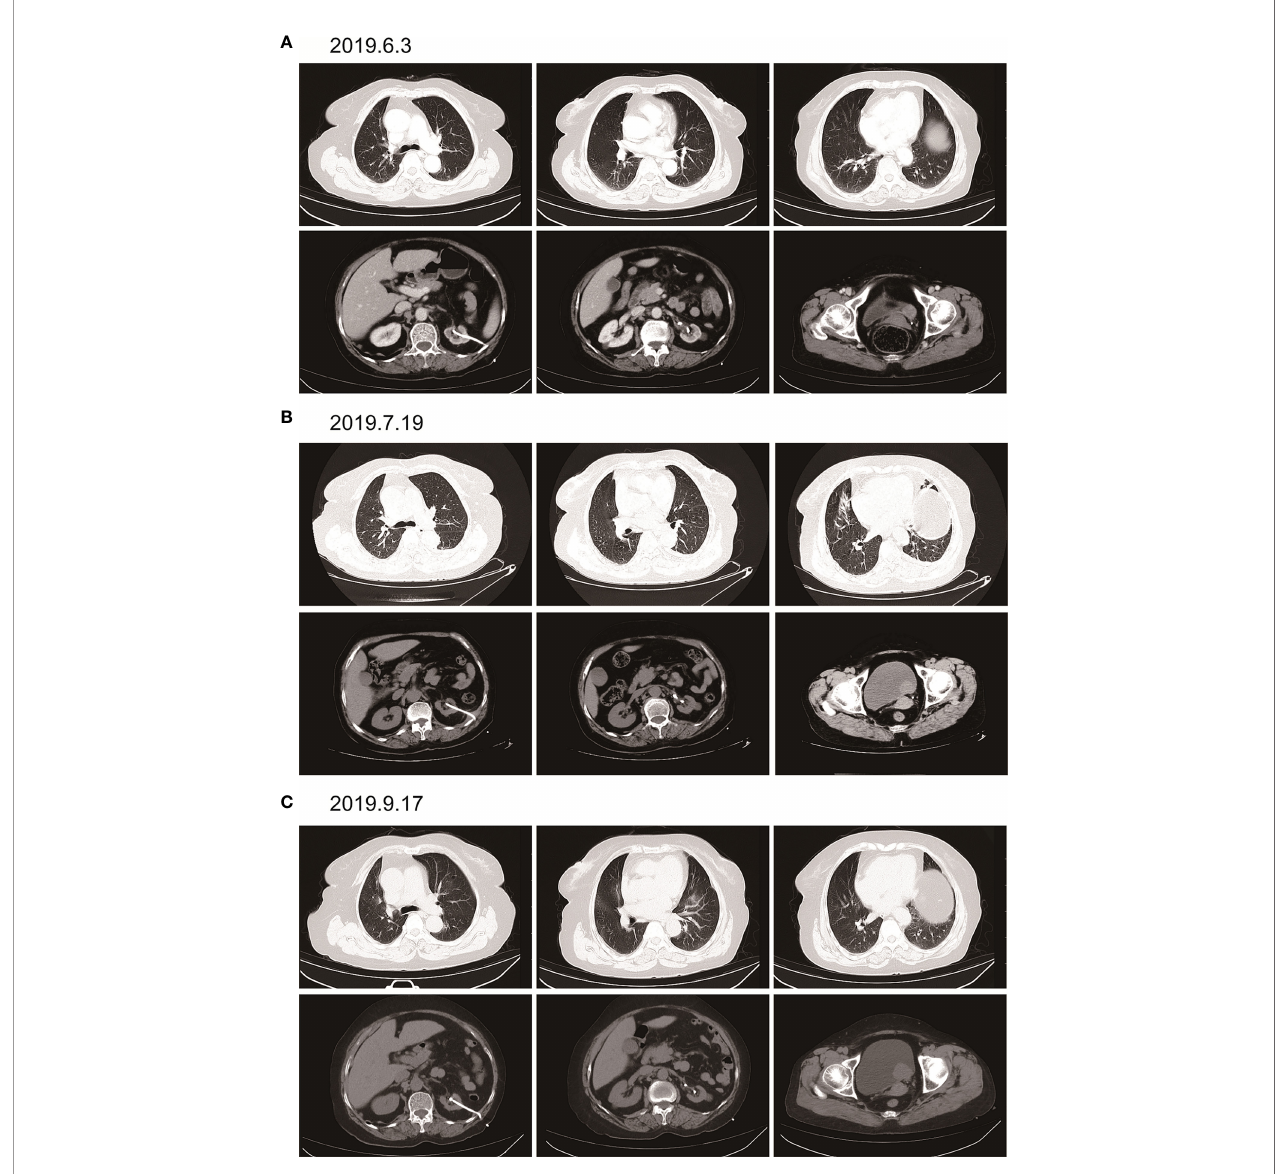
FIGURE 2 | Imaging examination after single-agent gemcitabine chemotherapy. (A) (2019.6.3) after two cycles of gemcitabine. Multiple round small nodules are seen in both lungs, with clear borders and reduced size compared to the previous ones. A dense mass of soft tissue at the entrance of the ureter on the left side of the bladder, with a size of about 25mm*22mm, and a clear boundary. (B) (2019.7.19) after 4 cycles of gemcitabine. Multiple round-shaped nodules in both lungs, with clear boundaries and slightly smaller than before. A dense mass of soft tissue at the entrance of the ureter on the left side of the bladder, with a size of about 25mm*22mm, with a clear boundary. (C) (2019.9.17) after 6 cycles of gemcitabine. Multiple round nodules in both lungs, with clear boundaries, and some were slightly larger than before. The soft tissue density mass at the entrance of the ureter on the left side of the bladder is shadowed, about 37mm*30mm in size, with a clear boundary and larger than